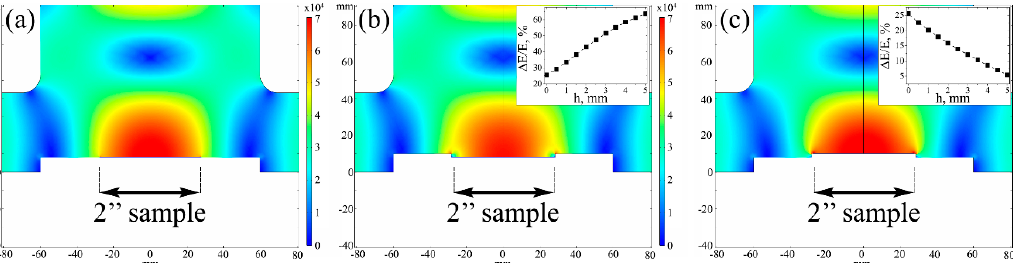
Figure 1. Schematic for the tested flat ( a ), pocket ( b ), and pedestal ( c ) holder geometries.